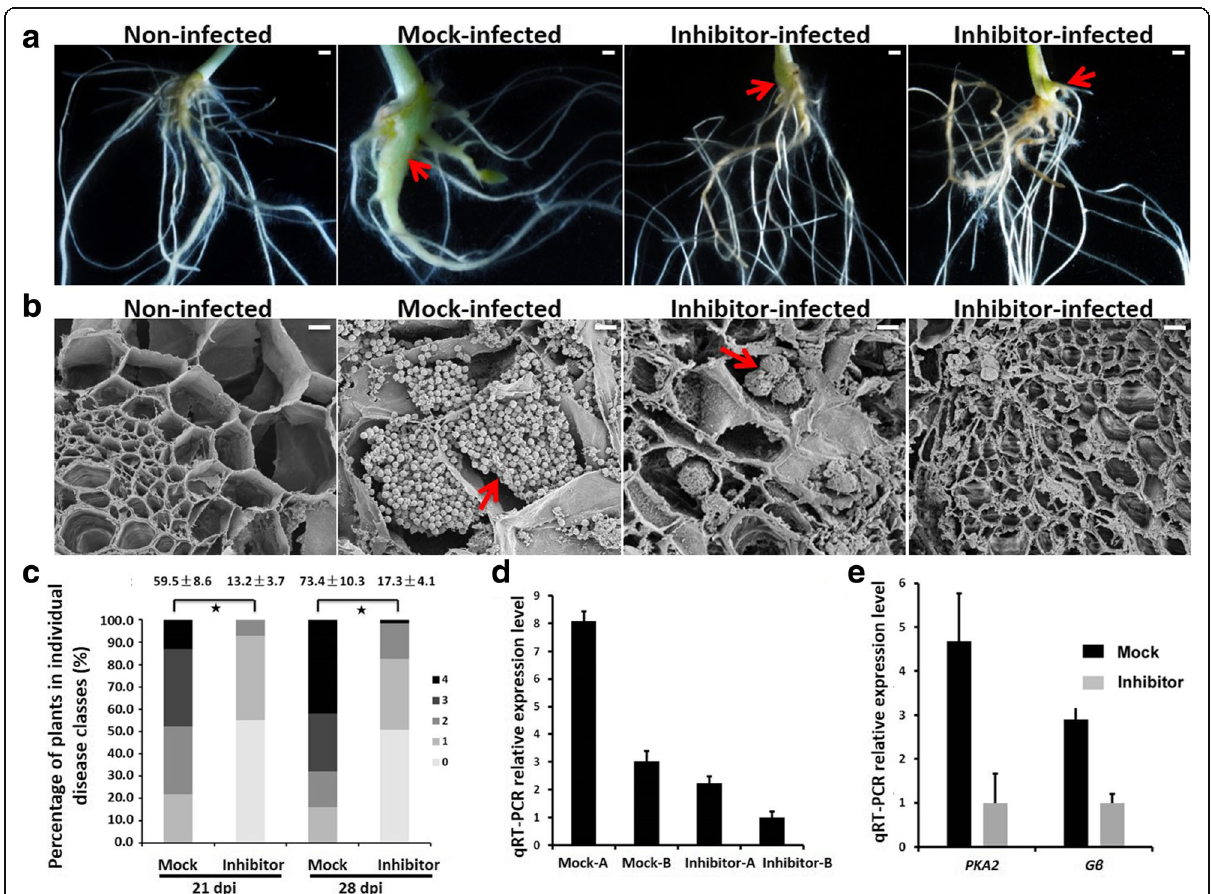
Fig. 6 The effect of GPCR inhibitor treatment on the symptom of clubroot. Clubroot symptoms ( a , b , c ) and quantification of Plasmodiophora brassicae DNA (d) in infected roots of the host plants treated or not with GPCR inhibitor. a Illustration of clubroot symptoms of GPCR inhibitor non-treated and treated plants at 28 dpi. Bar = 1 mm. b The transverse section of plant root tissues were observed by SEM. The red arrows indicate the typical infection structure of pathogen. Bar = 10 μ m. c Clubroot symptoms of 70 infected roots from three biological repeats were evaluated by using percentage of plants in individual disease classes and DI at 21 and 28 dpi. Asterisks indicate statistically significant differences at the level of P < 0.01 according to Student ’ s t test. d At 28 dpi, the infected roots of mock-treated plants and inhibitor-treated plants were divided into two groups (A: severe; B: less severe). The relative accumulated amount of pathogen DNA was quantified by qPCR. Error bars represent the SE with three technical repeats. e The expression levels of the primary downstream genes of GPCR in cancer related pathway. Error bars represent the SD with three technical